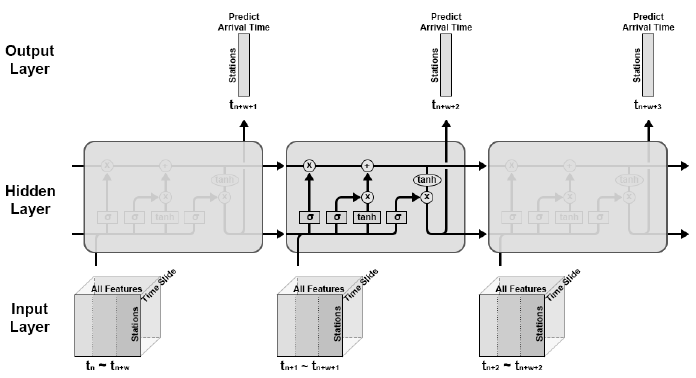
Figure 4. Using LSTM for modeling the correlation between the tensors of comprehensive features and the bus arrival time prediction at every time